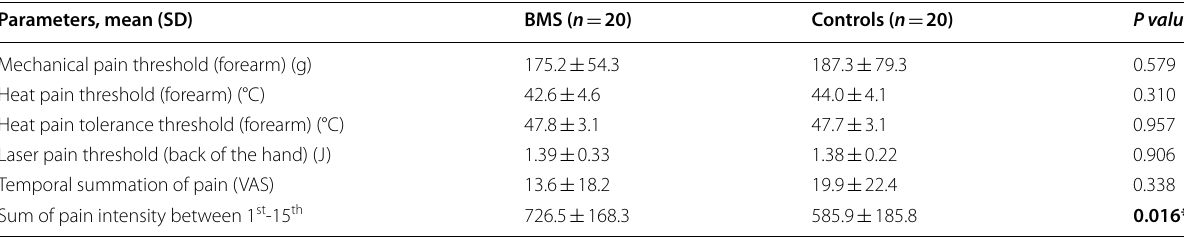
Abbreviations: g gramme, J Joule, SD Standard deviation